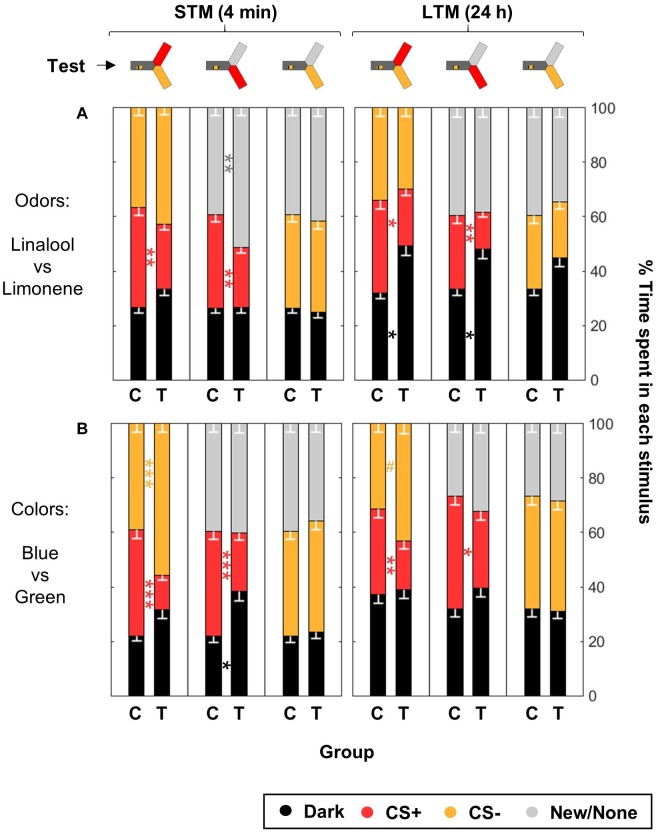
Differential conditioning produces aversive learning of the CS+ but not safety learning of the CS–. During training, shocks were paired with the CS+ but not the CS– for trained animals (T), while control bees (C) received shocks unpaired from both CS. After training, the bees were confronted to three tests: CS+ vs. CS–, CS+ vs. New/None and CS– vs. New/None. Each bee participated in all tests. For each group of bees, the percentages of time spent in the environments available during a given test (e.g., dark, CS+, and CS–) are plotted and stacked into a single bar. Since we included all environments, the resulting stack always totalize 100% (the whole test duration). Data is represented as mean – SEM. n = 96 trained bees and 48 control bees for each sensory modality. Mann–Whitney U-tests comparing C to T, corrected with FDR, ∗p < 0.05, ∗∗p < 0.01, ∗∗∗p < 0.001, #0.05 > p > corrected threshold. (A) In the case of odors, bees were trained with Linalool and Limonene, and each odor was tested against a blank control (because of the dim blue illumination used to make the choice arms attractive during odor tests, the choice was thus blue vs. blue + odor). (B) In the case of colors, bees were trained with blue and green, and the novel color was UV.